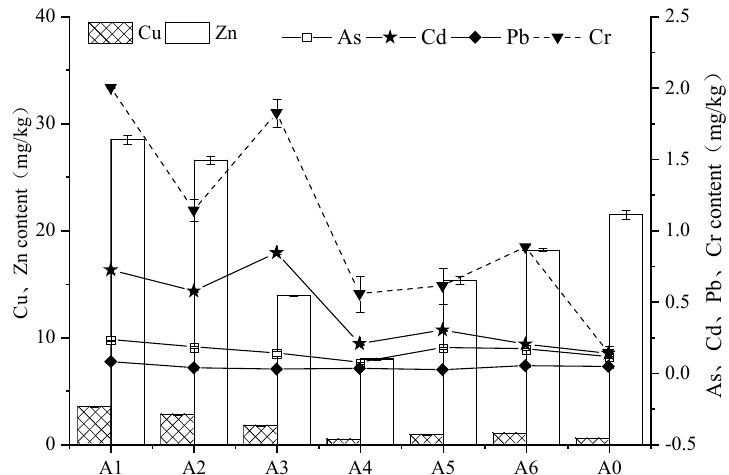
Figure 5. Changes in heavy metal content in soft tissue of surface barnacle at different monitoring stations (wet weight).